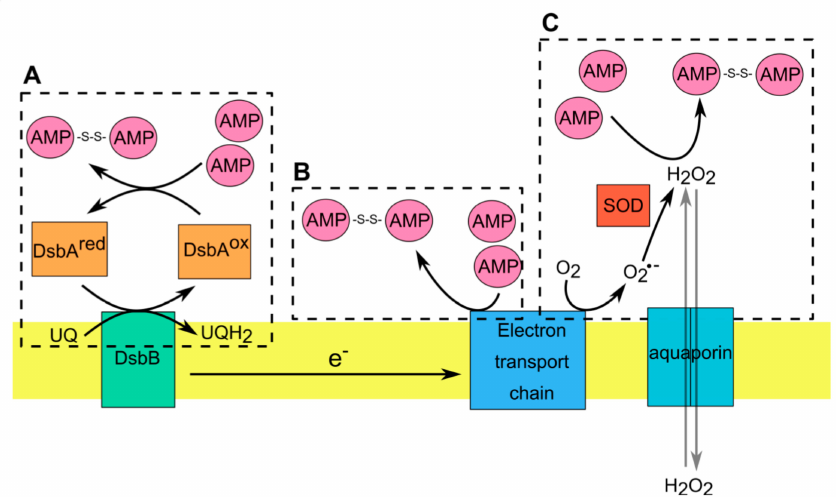
Figure 2. AMP interactions with the redox-active components in Gram-negative bacteria. ( A ). Disul- fide bond formation is catalyzed in periplasm by DsbA (ox), that becomes reduced following the transfer of disulfide to substrate proteins (such as AMPs). DsbB mediates the reoxidation of DsbA via transfer of electrons from DsbA to the respiratory chain. ( B ). Within electron transport chain (ETC) some cofactors have a redox potential high enough to allow direct electron transfer from these cofactors to AMPs with formation of dimeric AMPs. ( C ). Hydrogen peroxide (H 2 O 2 ) generated during normal or aberrant aerobic respiration induce the formation of disulfide bonds in